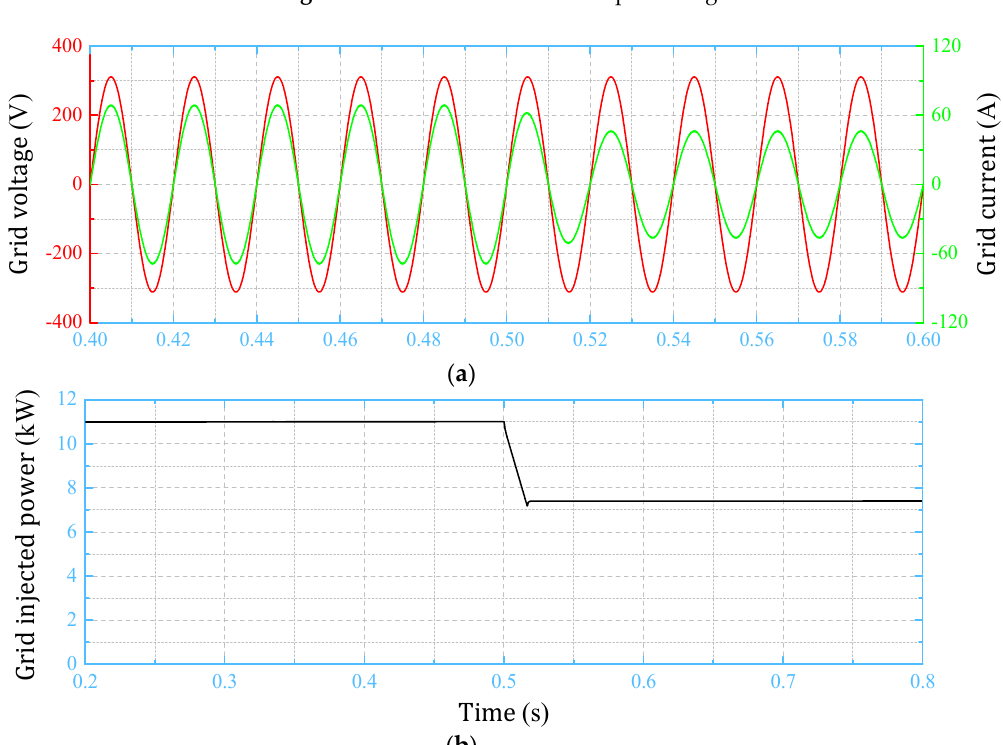
Figure 9. The injected current, voltage, and power variation. ( a ) Grid voltage and current; ( b ) Grid injected power.